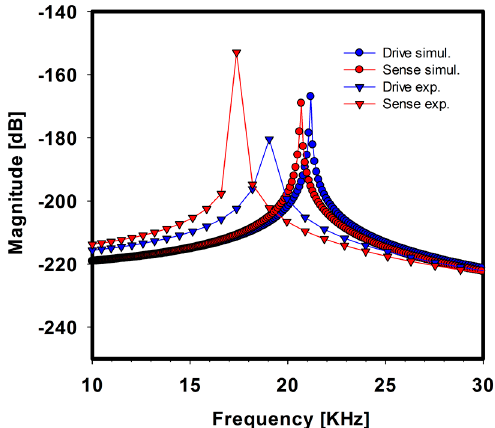
Figure 6. Comparison between the simulation and experimental results of the frequency sweep showing the natural frequency of each drive and